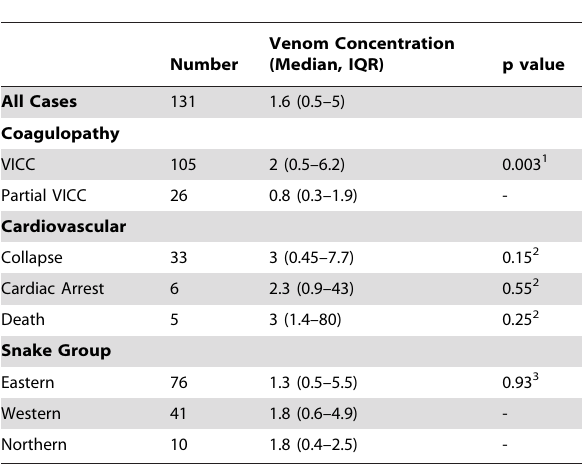
Table 6. Comparison venom concentrations for different clinical effects/severity and different Pseudonaja species